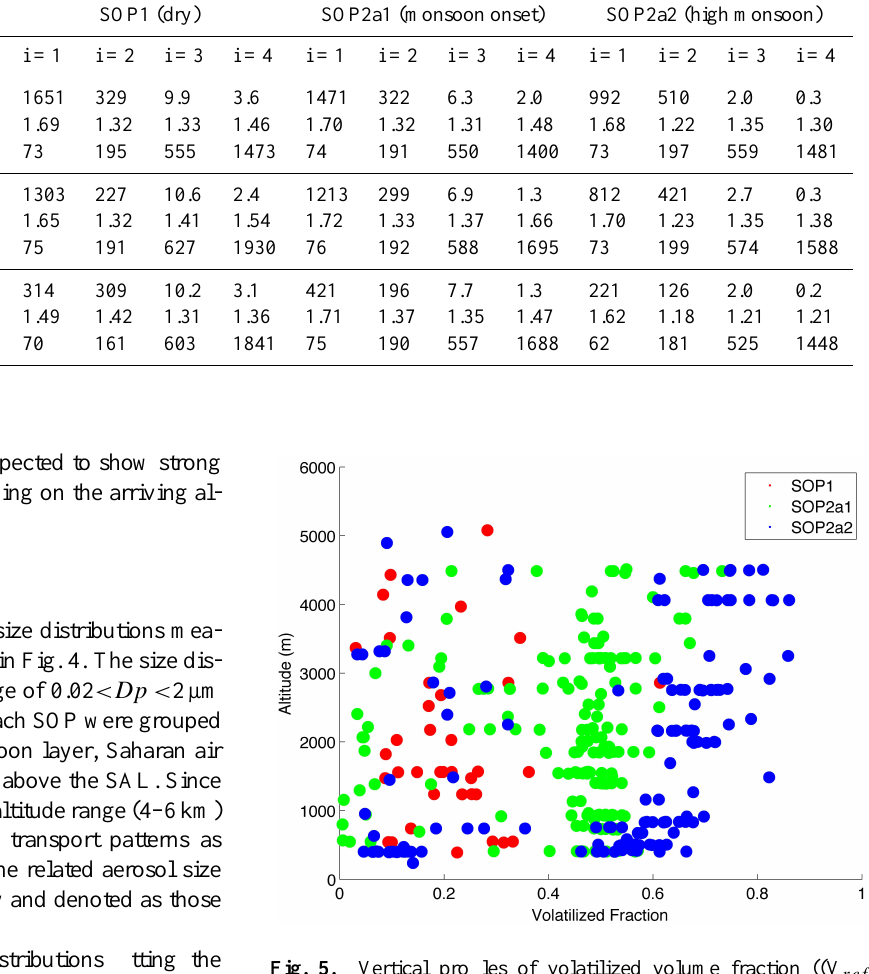
Fig. 5. Vertical profiles of volatilized volume fraction ((V ref – V 285 ) /V ref ) derived by comparing the reference and heated (285 ◦ C) volume size distributions. The considered size range is limited to 20 < Dp <